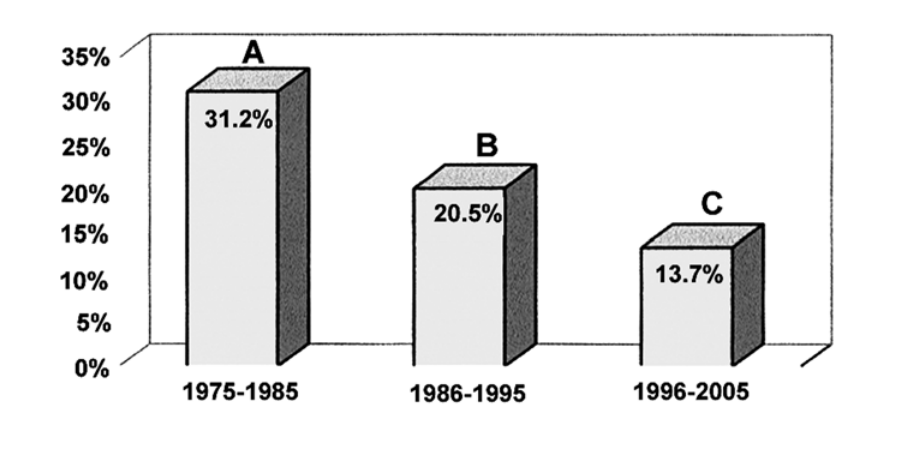
Figure 2 – Presence of renal scars at the time of diagnosis (n = 511), at the diferents groups; p =